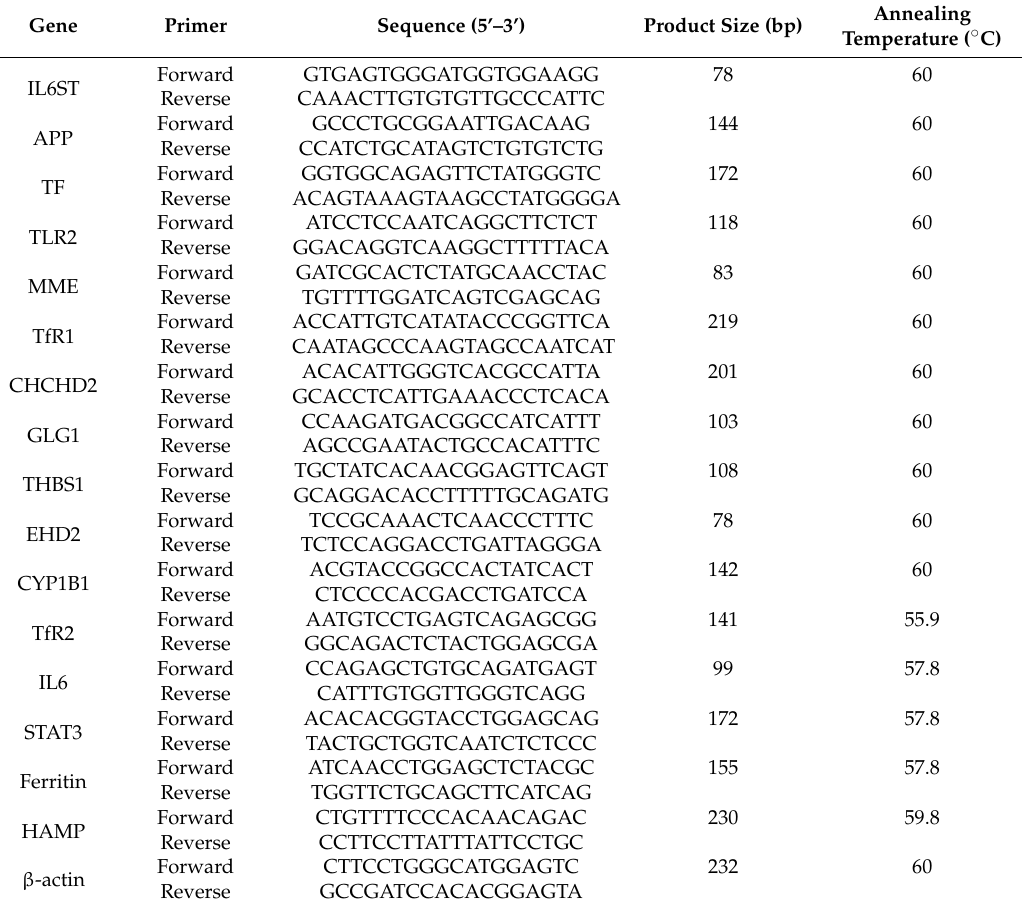
Table 3. Forward and reverse primer sequences, annealing temperature and product size for different